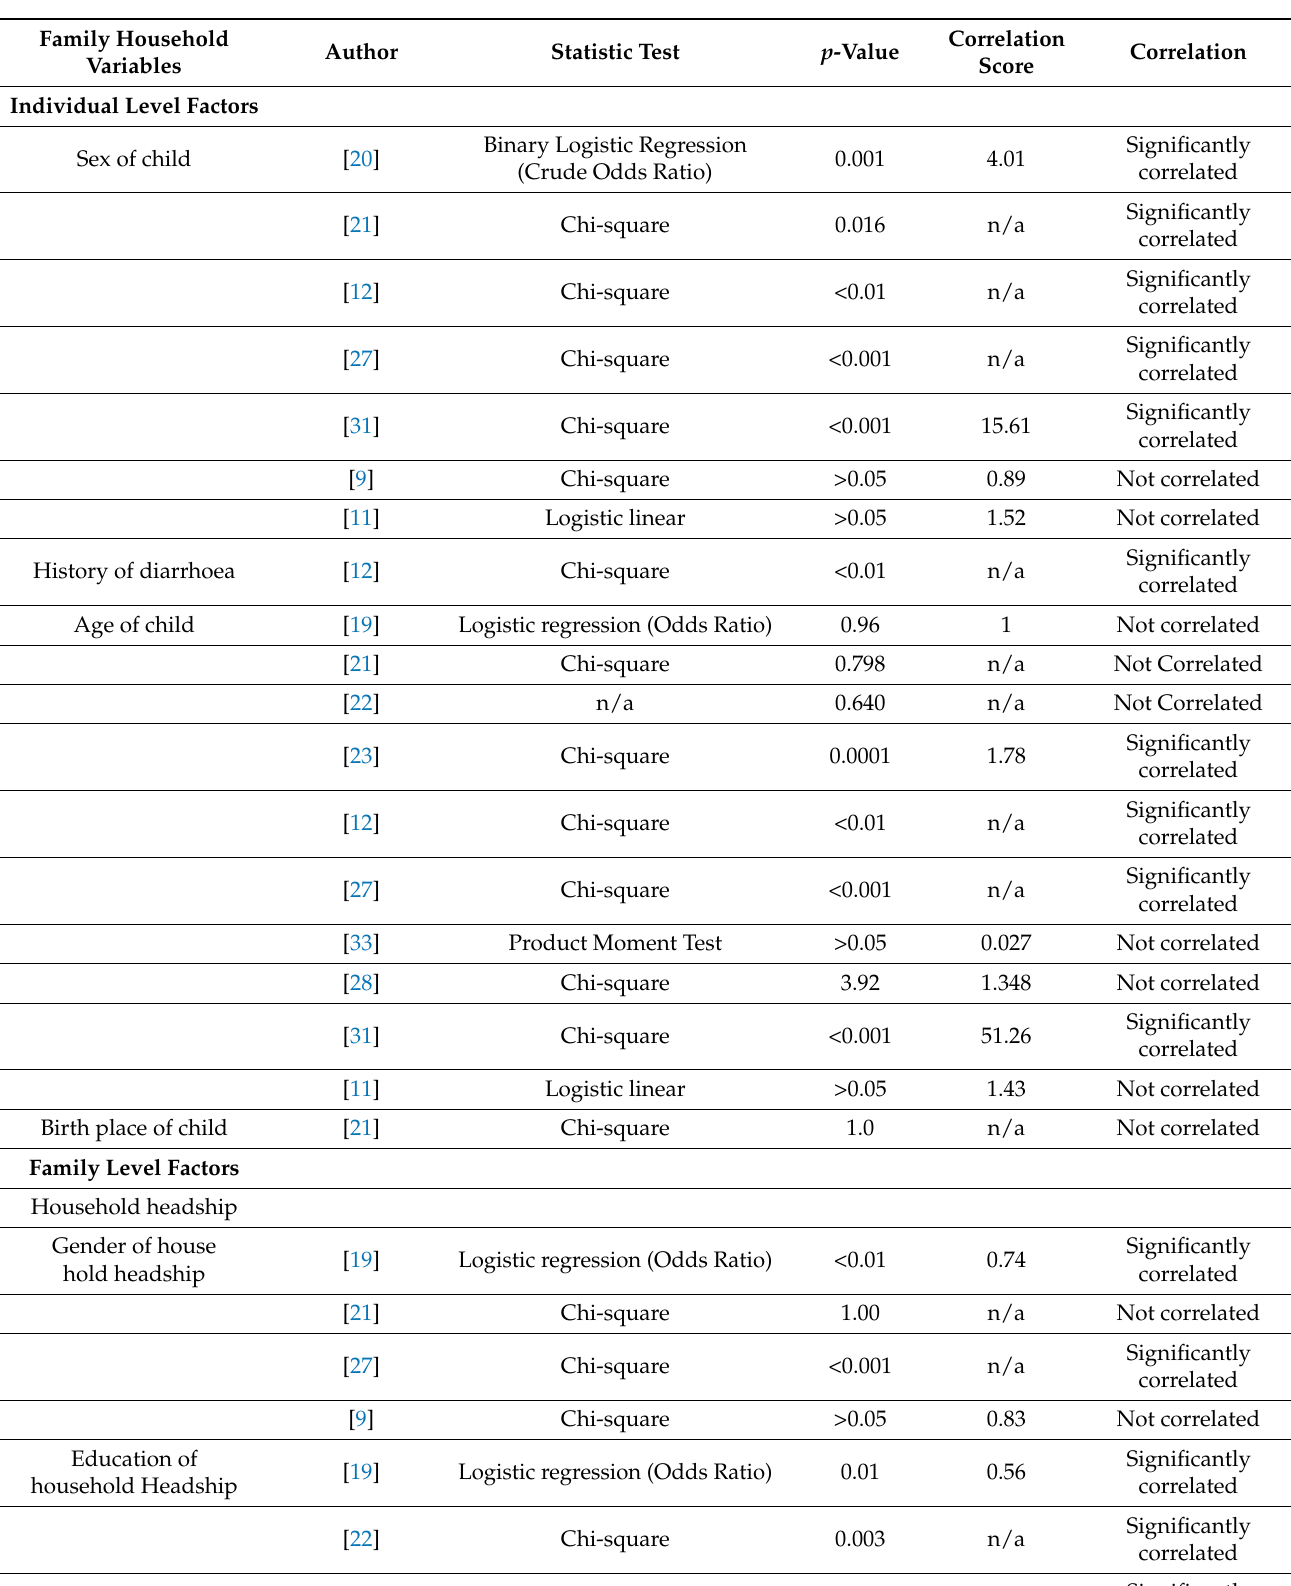
Table 3. The Correlation between Family Household Characteristics and Stunting Prevalence ( n =